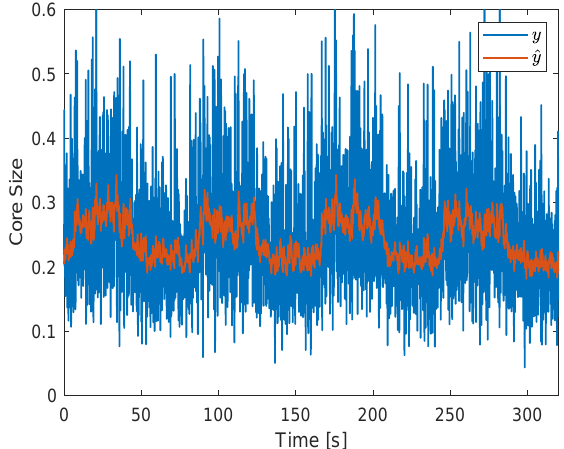
Figure 24. Uncontrolled core size obtained for a square wave disturbance in the air flow rate of the experimental facility. In blue: original ERT signal. In orange: output of the low-pass filter ( ω f = 1 rad/s). Signals with standard deviation σ ( y ) = 0.0902 and σ ( ˆ y ) =